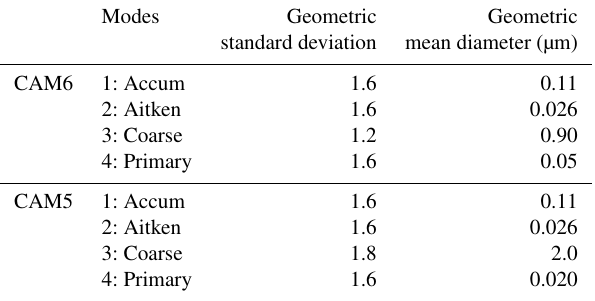
Table 1. MAM mode size parameters in CAM5 and CAM6 by de- fault. We reverted the coarse mode parameters in CAM6 to those in CAM5 in our CAM6